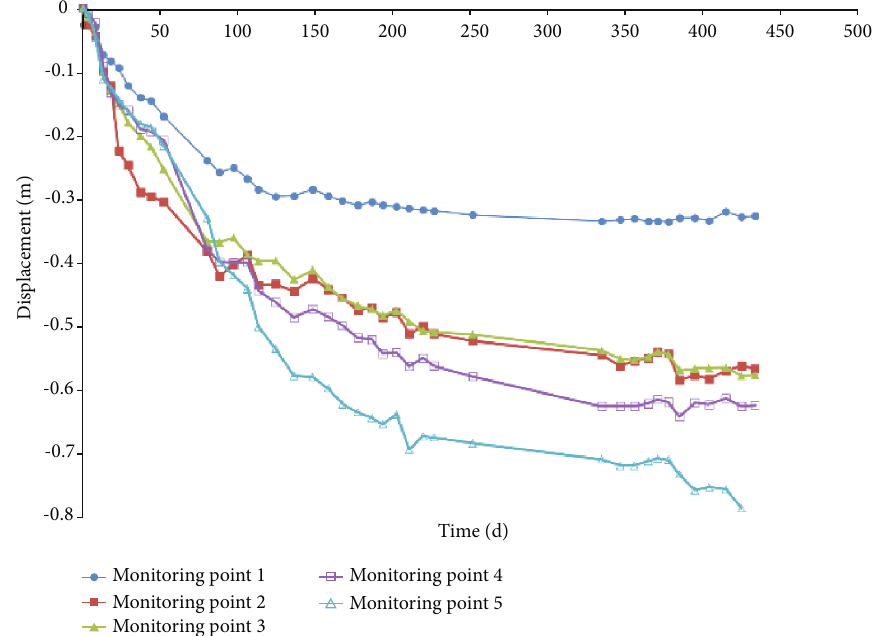
Figure 9: Curves of the time and displacement of the dam surface.